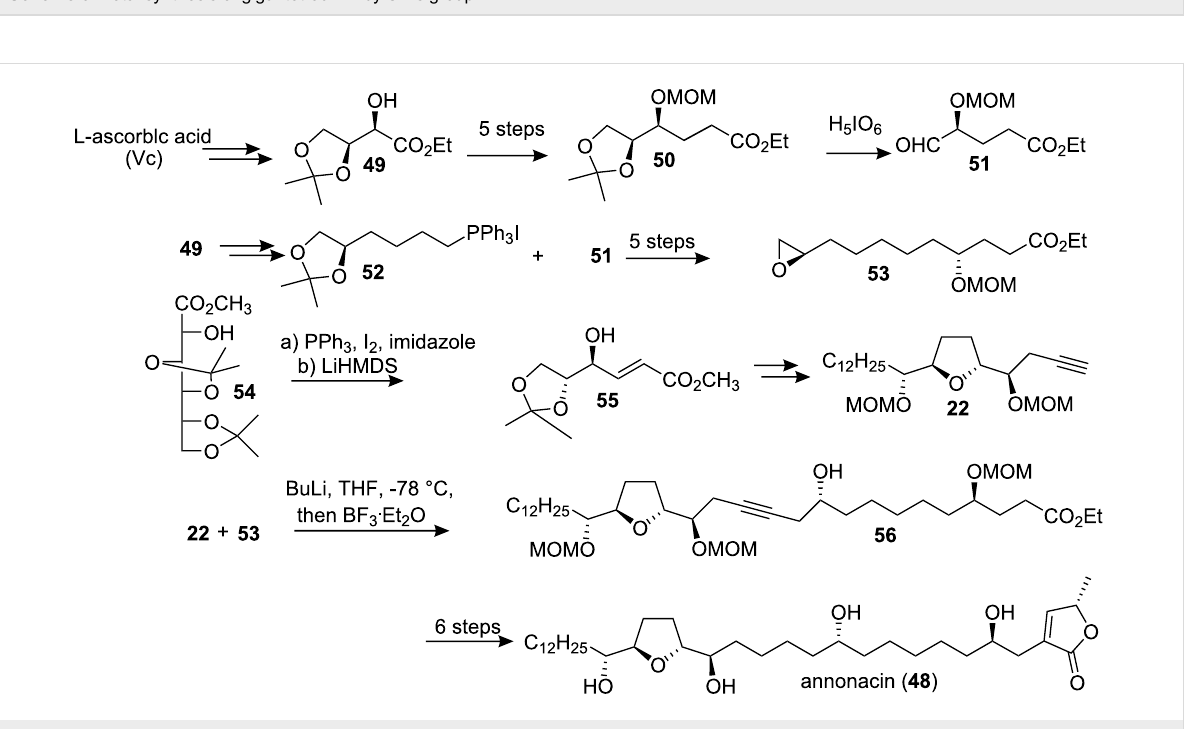
Scheme 7: Total synthesis of annonacin by Wu’s